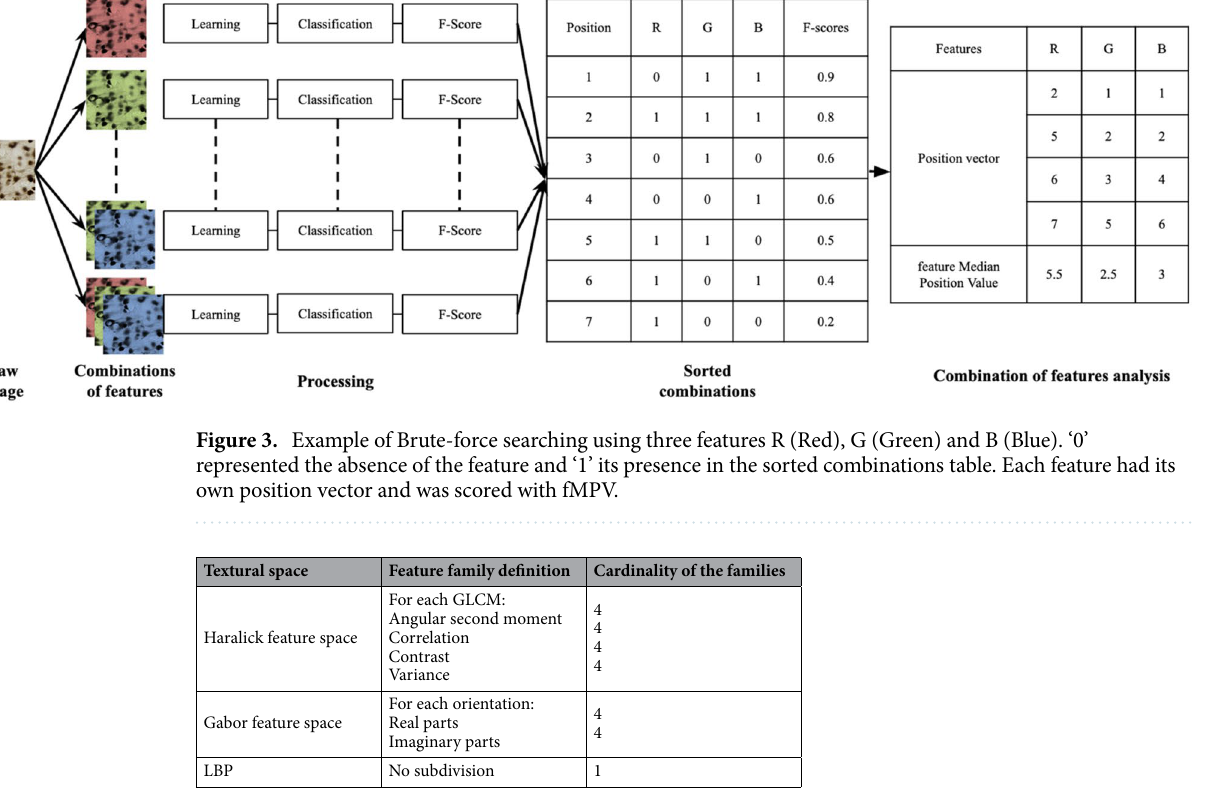
Table 2. Sum up of textural feature families cardinality for different feature